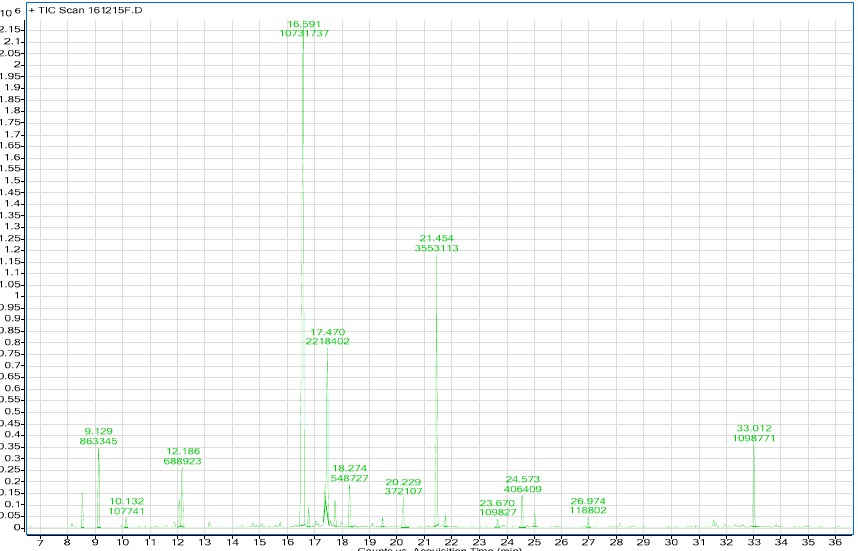
Figure 3. Chromatogram of gas chromatography analysis of Achillea odorata subsp. pectinata essential oil.